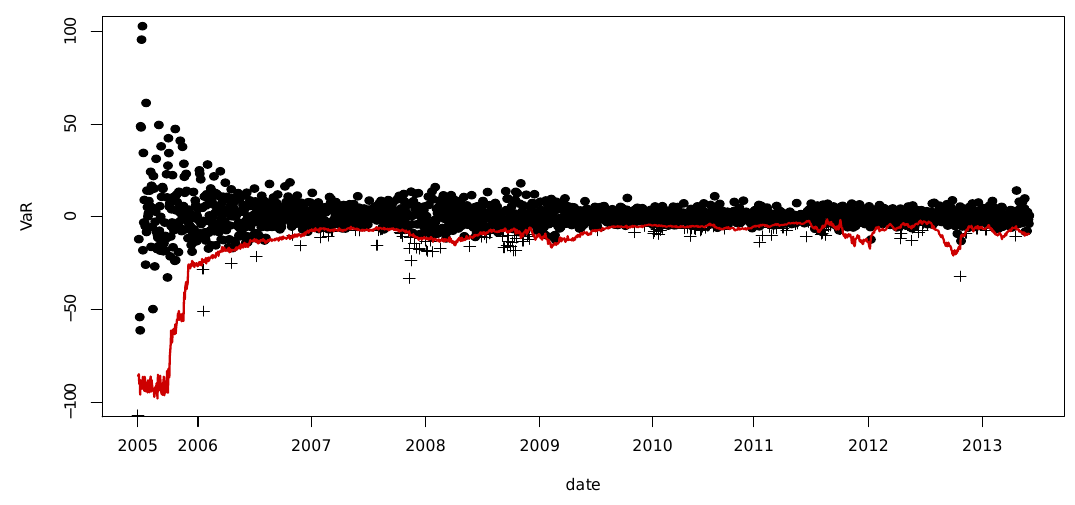
Figure 4: Exceedances plot for VaR ( α ) with α = 0.05 on the IBM-Google portfolio for the rolling window model. The dots repre- sent the empirical portfolio value stated by the data, the “+” signs correspond to the exceedances.